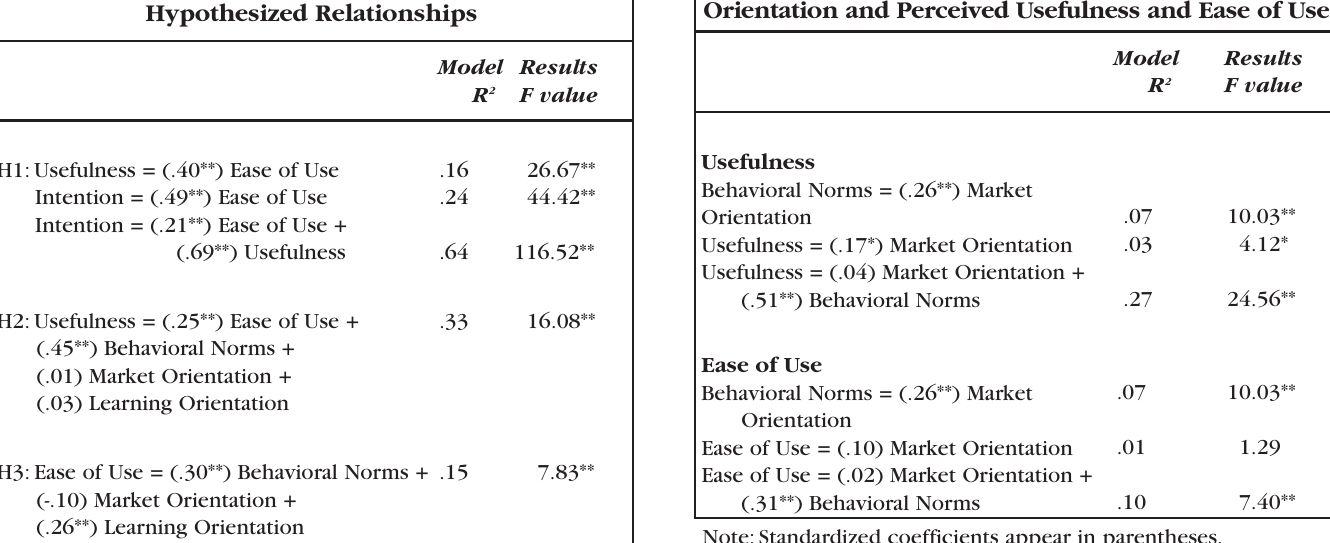
Table 3. Post Hoc Regression Analyses Testing the Mediating Effects of Behavioral Norms on